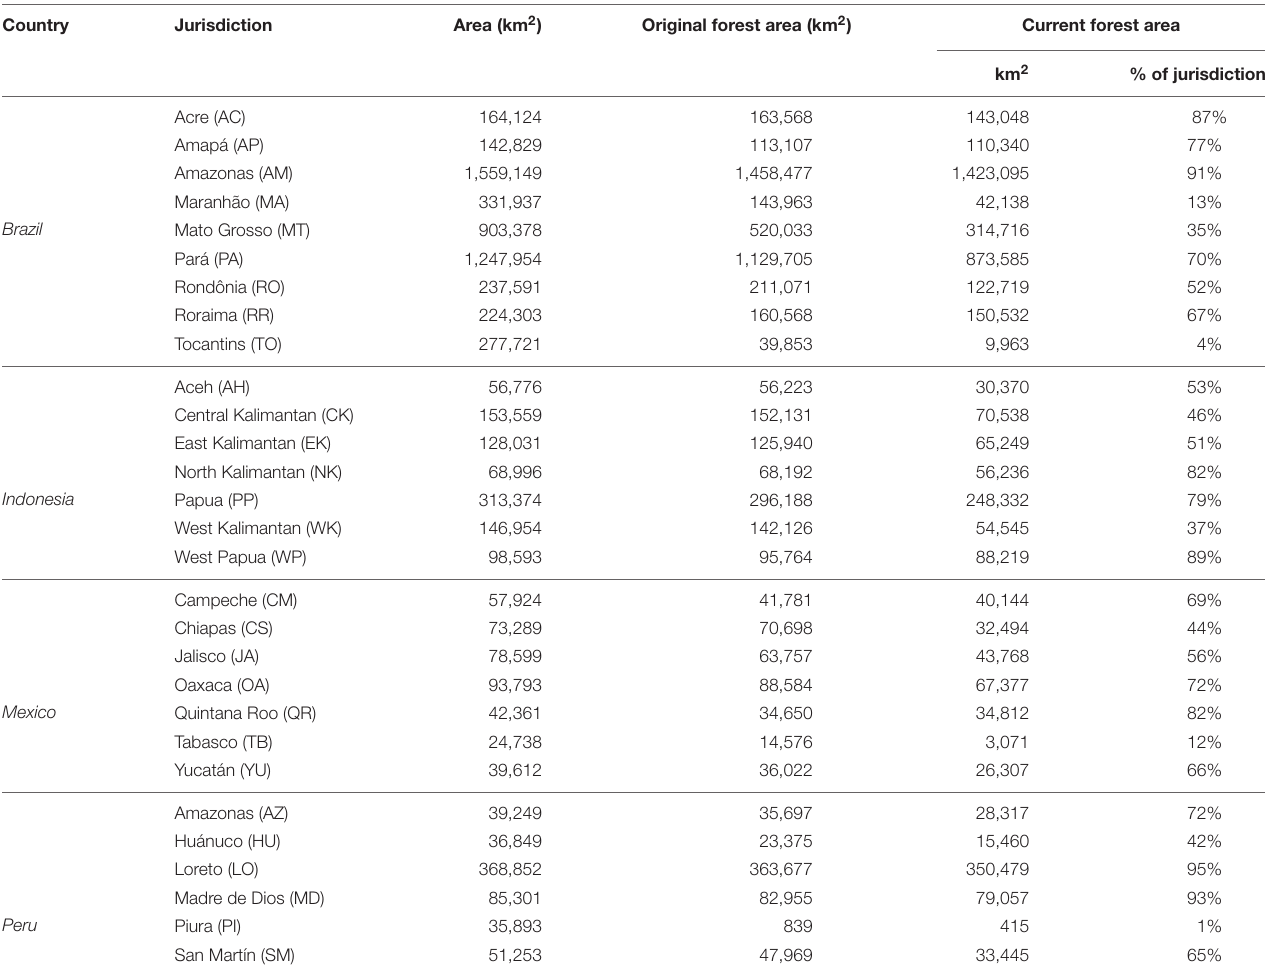
TABLE 1 | Total surface area, original forest area, and current forest area of study jurisdictions.